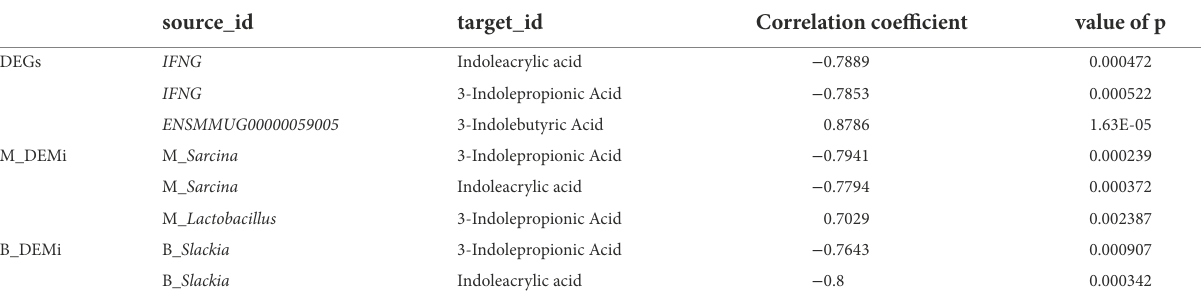
TABLE 1 The correlation top three of tryptophan metabolites with DEGs and